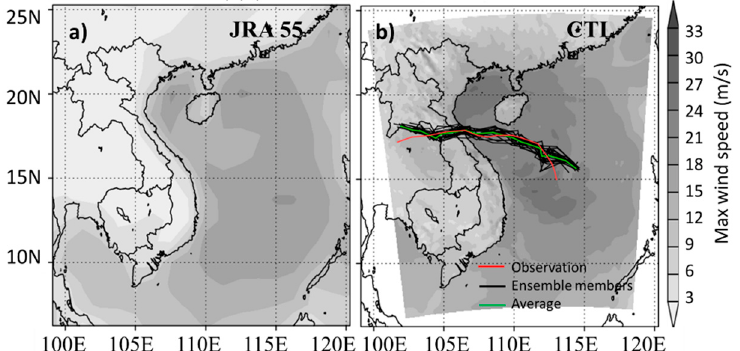
Figure 5. ( a ) Maximum wind speed (MWS) from the Japanese 55-year Reanalysis (JRA-55) dataset and ( b ) average MWS and track of typhoon Lekima simulated by WRF models, where the black line and green line each represent the average track of nineteen ensemble members, and the red line is the track observed by the JMA.